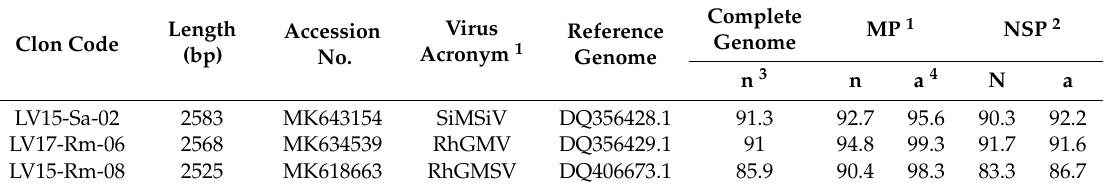
1 MP: Movement protein. 2 NSP: Nuclear shuttle protein. 3 n: Nucleotide homologies in %. 4 a: